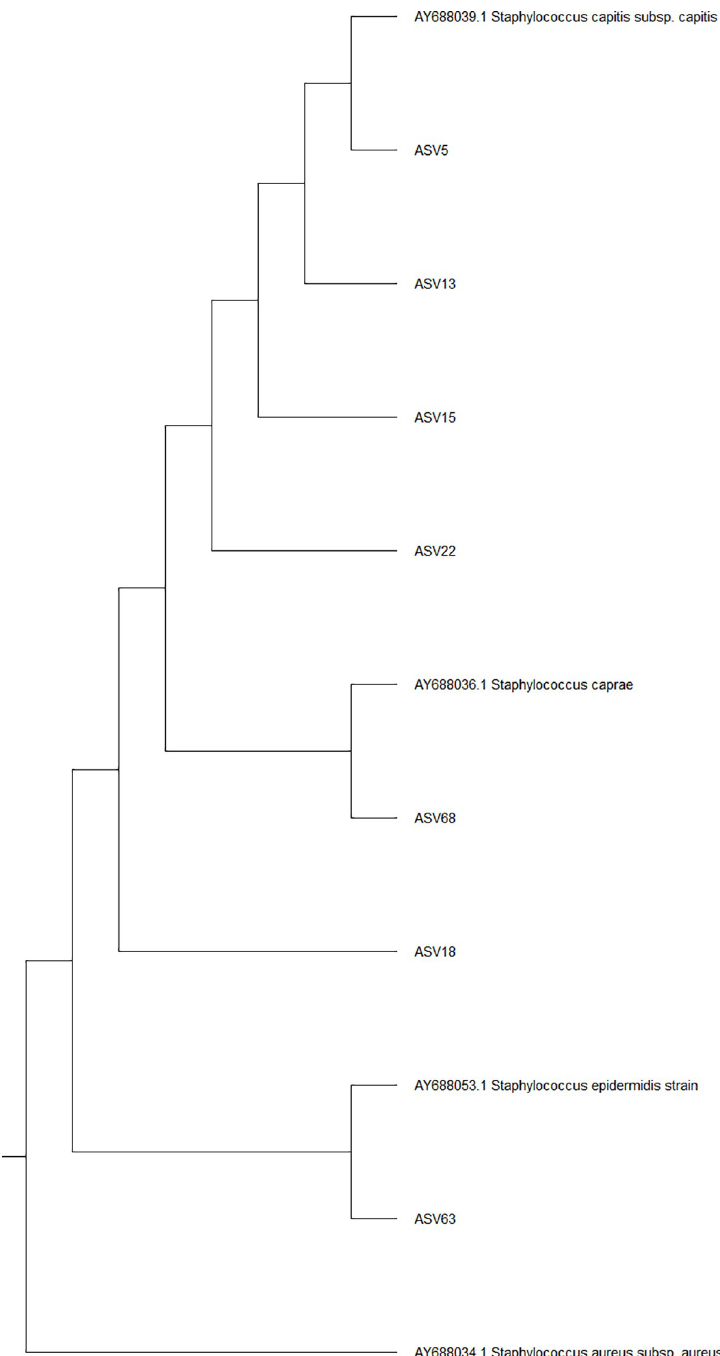
Fig 5. Phylogenetic tree of the ASVs with suggestive differences in composition between lesional SD and controls. Fig 5 depicts the phylogenetic relationship between ASVs assigned to Staphylococcus species and Staphylococcus species obtained from GenBank (16S rRNA sequence). This sequences begin with AY � . ASVs closely related to S . capitis belong to the same node (ASV5, ASV13, ASV15 and ASV22). ASV68 appears to belong to S . caprae together with ASV18. ASV63 clustered with S . epidermidis . Sequence of S . aureus appear as outgroup (sequence with most